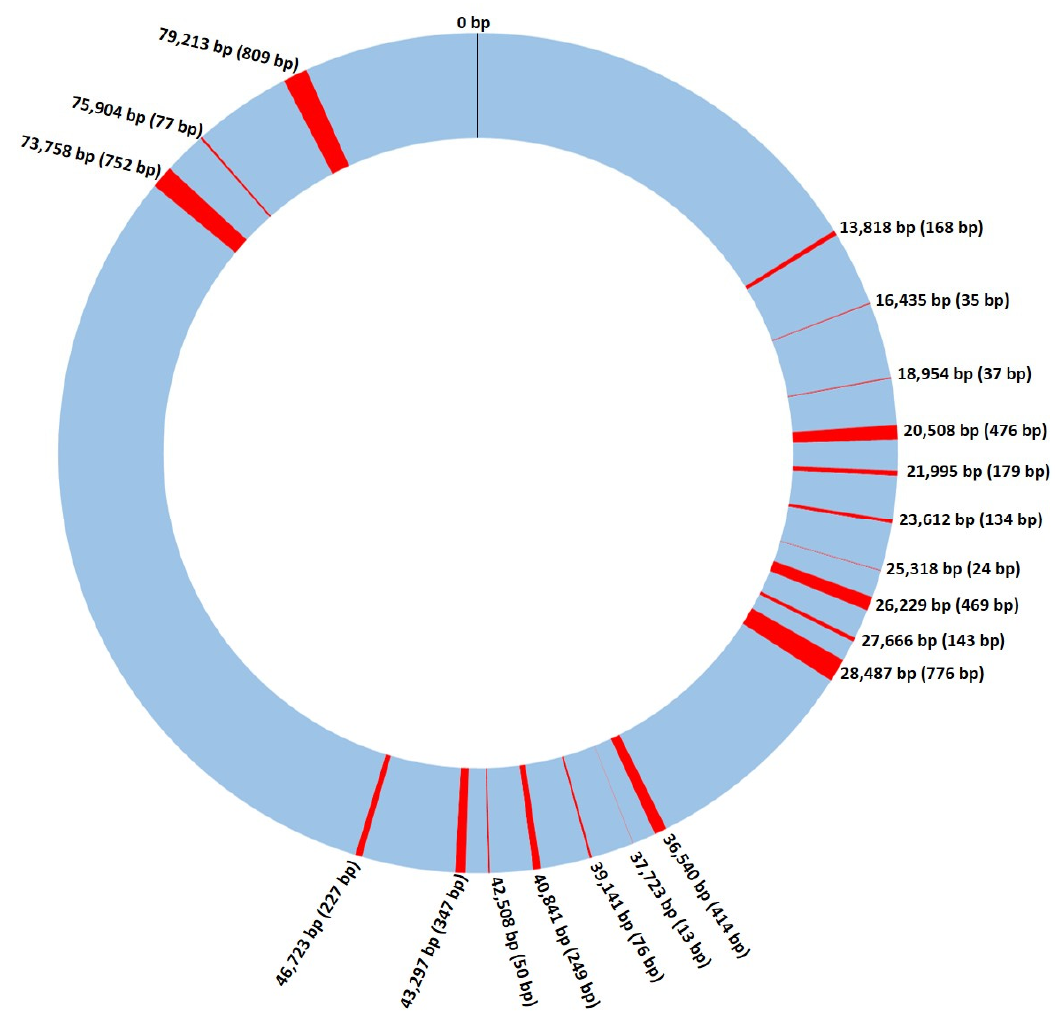
Figure 1. Schematic representation of the Saccharomyces cerevisiae mitochondrial genome. DNA regions used in the analysis shown throughout this work are marked in red, with the numbers representing its position on the genome (first base pair), and the numbers inside the brackets the size of each region. bp—DNA base pairs